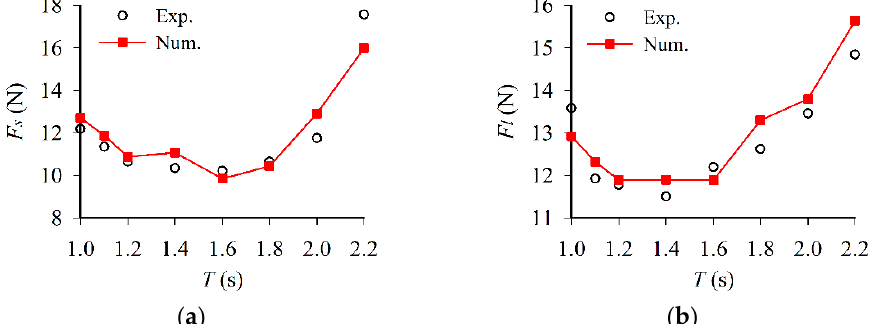
Figure 11. Comparison of the experimental and numerical mooring force of the dual cylindrical floating pontoon: ( a ) Seaward side F s ; ( b ) Leeward side F l . floating pontoon: ( a ) Seaward side F s ; ( b ) Leeward side F l